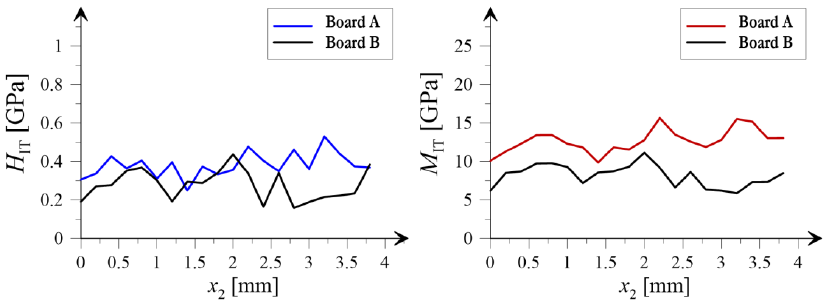
Figure 14. Average values of hardness ( H IT ) and indentation modulus ( M IT ) in the x 1 direction.